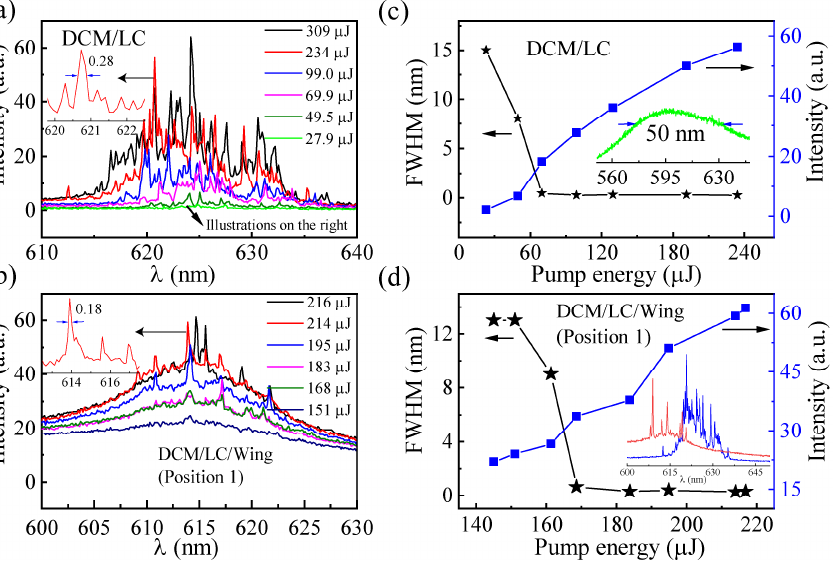
Figure 3. Emission spectra as a function of pumping energy for ( a ) DCM/LC and ( b ) DCM/LC/Wing; The emission intensity (blue squares) and full-width at half-maximum (black stars) as a function of the pumping energy for ( c ) DCM/LC and ( d ) DCM/LC/Wing. Illustration in ( c ): Enlargement of the green line in ( a ). Illustration in (d): The evolution of emission spectra recorded for DCM/LC and DCM/LC/Wing at the pump energy of 234 uJ.